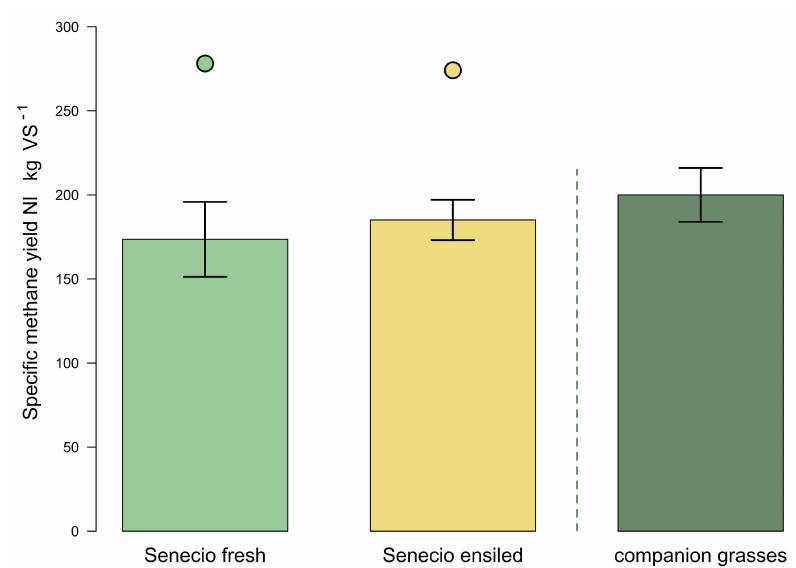
Figure 4. Specific methane yields of fresh and ensiled biomasses from J. vulgaris . Presented are the means and the corresponding standard deviations as error bars. Dots mark the amount of specific methane yield potential according to Weißbach (2008). For comparison, the yield of the prevalent companion grasses according to Meserszmit et al. (2019) is additionally shown.